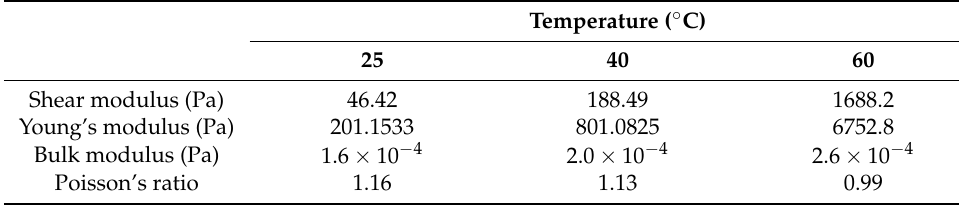
Table 6. Elastic properties of rice paste (sample 100:80).